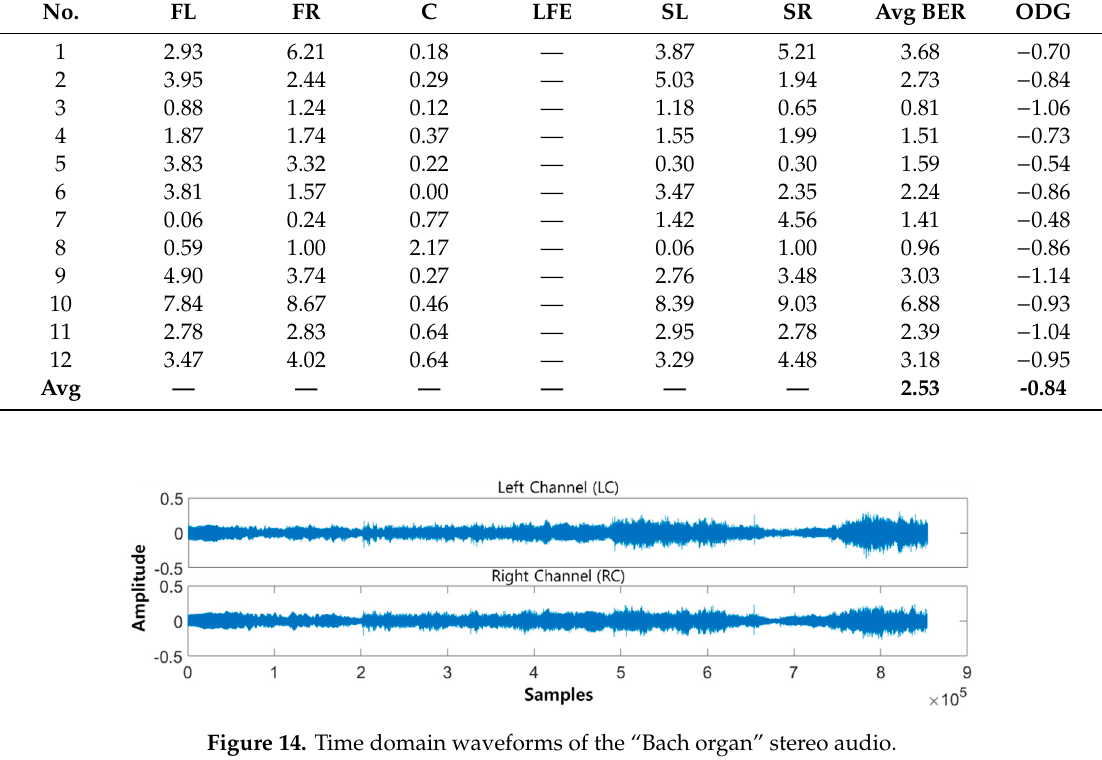
Table8. BER(%)andODGofeachchannelof5.1channelaudiounderHE-AACv1128kbpscompression. No.